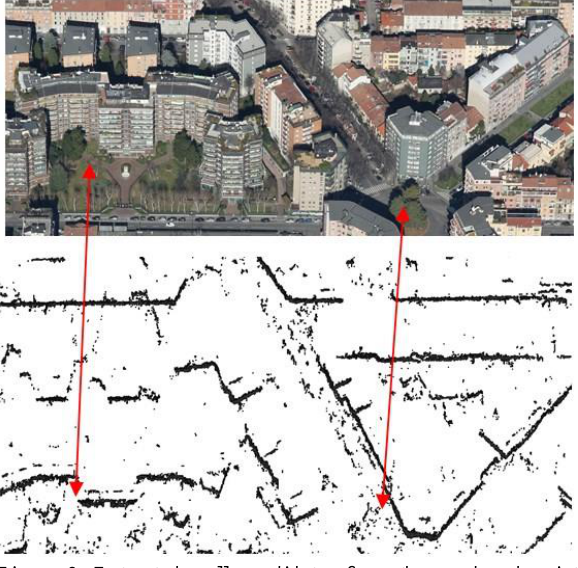
Figure 6. Extracted wall candidates from the produced point clouds. Some noise is still present in presence of